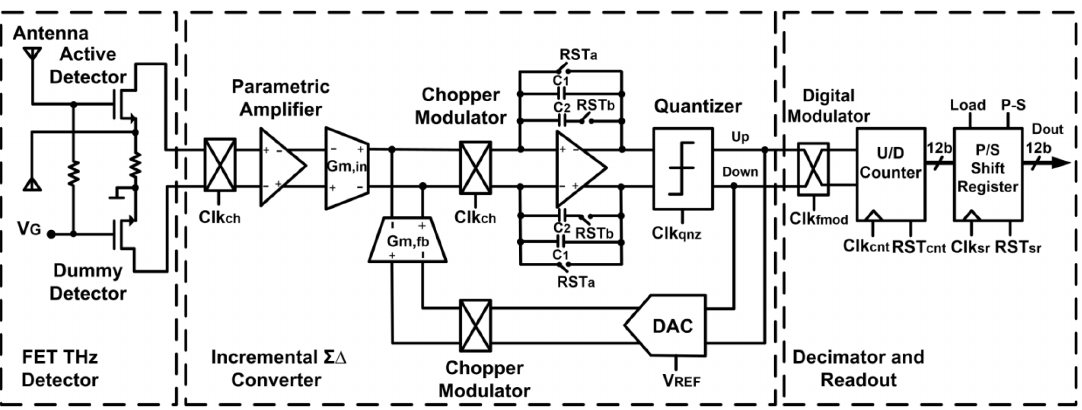
Figure 5. Block diagram of the proposed THz detector and readout